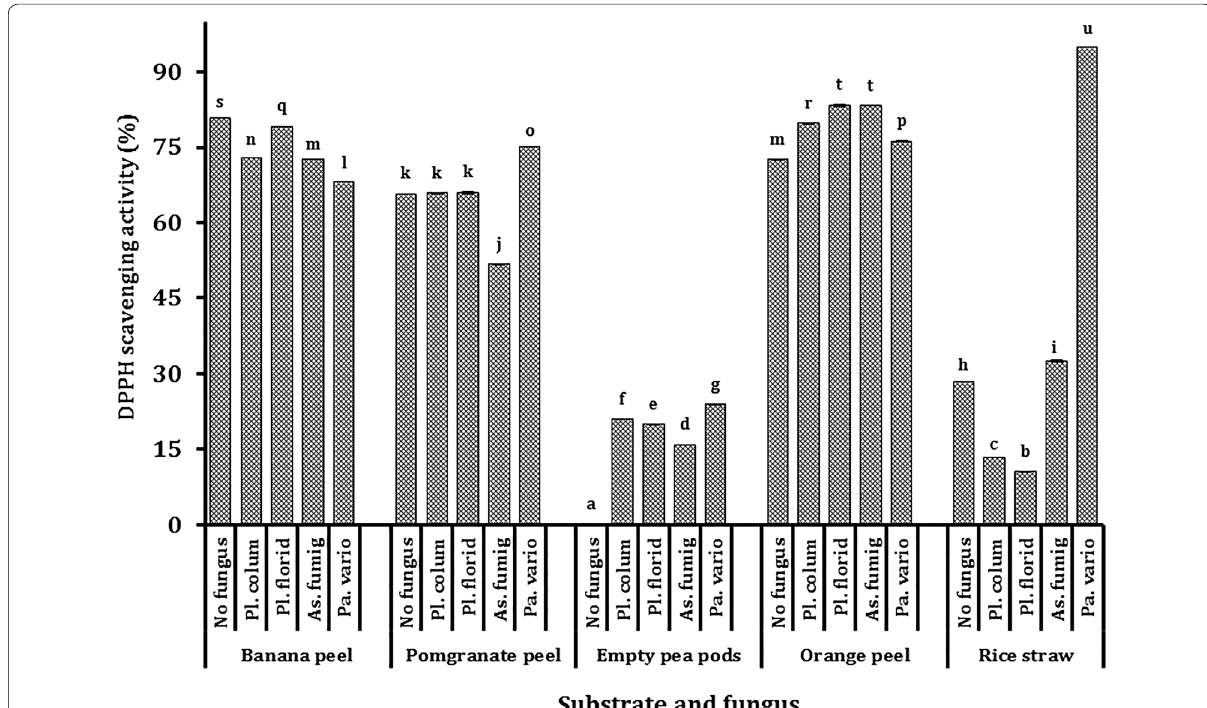
Fig. 4 DPPH scavenging activity of an SSFS employing two basidiomycete fungi: P. columbinus and P. floridanus and two ascomycetes: A. fumigatus and P. variotii on peels of banana, pomegranate and orange, empty pods of pea and rice straw. Each column represents the mean of three replicates SE. Columns with common letters are not significantly different at P < ±